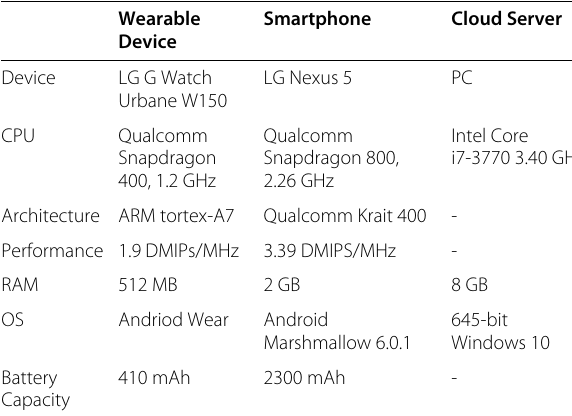
Table 2 Test Device